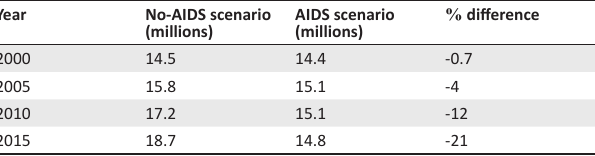
TABLE 3: Projected changes in the size of the labour force for the 2000–2015